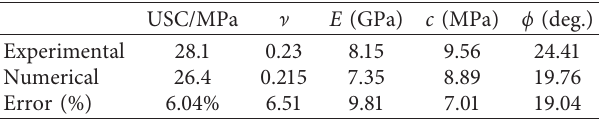
Figure 1: The stress-strain curves of coal under uniaxial compression. Table 1: Comparison of laboratory test and numerical simulation results.